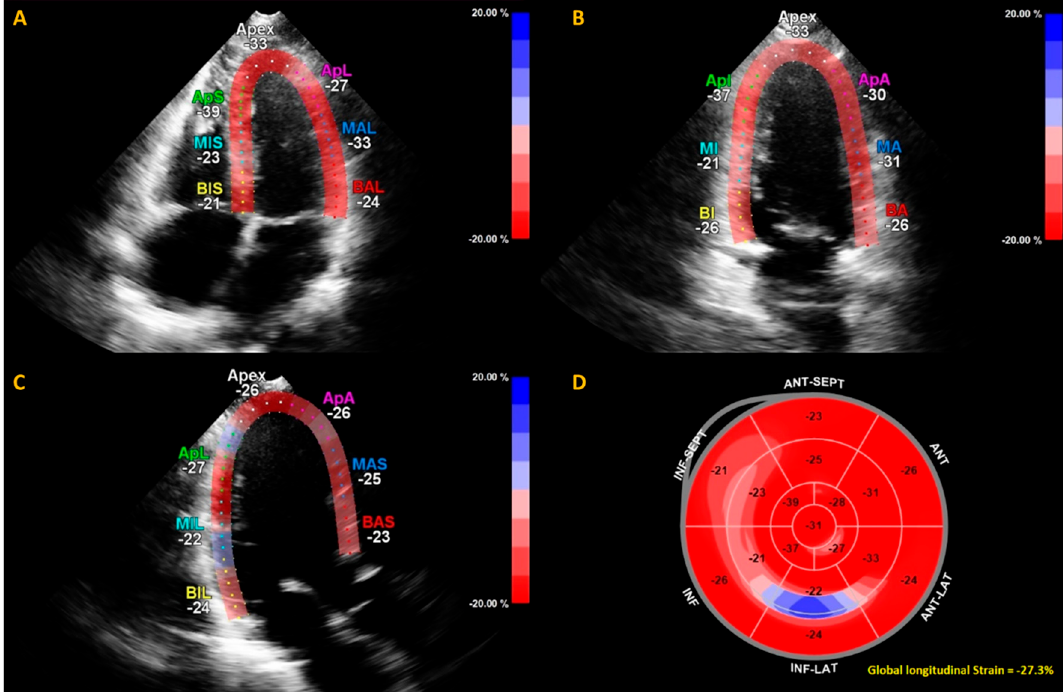
Figure 2. Example of calculation of global longitudinal strain (GLS) by speckle tracking for the apical four-, three- and two-chamber views ( A – C ). The strain during one cardiac cycle is shown for each of the color-coded (red and blue) left ventricular segments. The longitudinal strain bull’s eye plot ( D ) determined from 2D speckle tracking imaging offers a visual overview of the regional and global left ventricular myocardial function in a diagram. In this example of one of the subjects in this study, the GLS is − 27.3%, which is in the normal range.